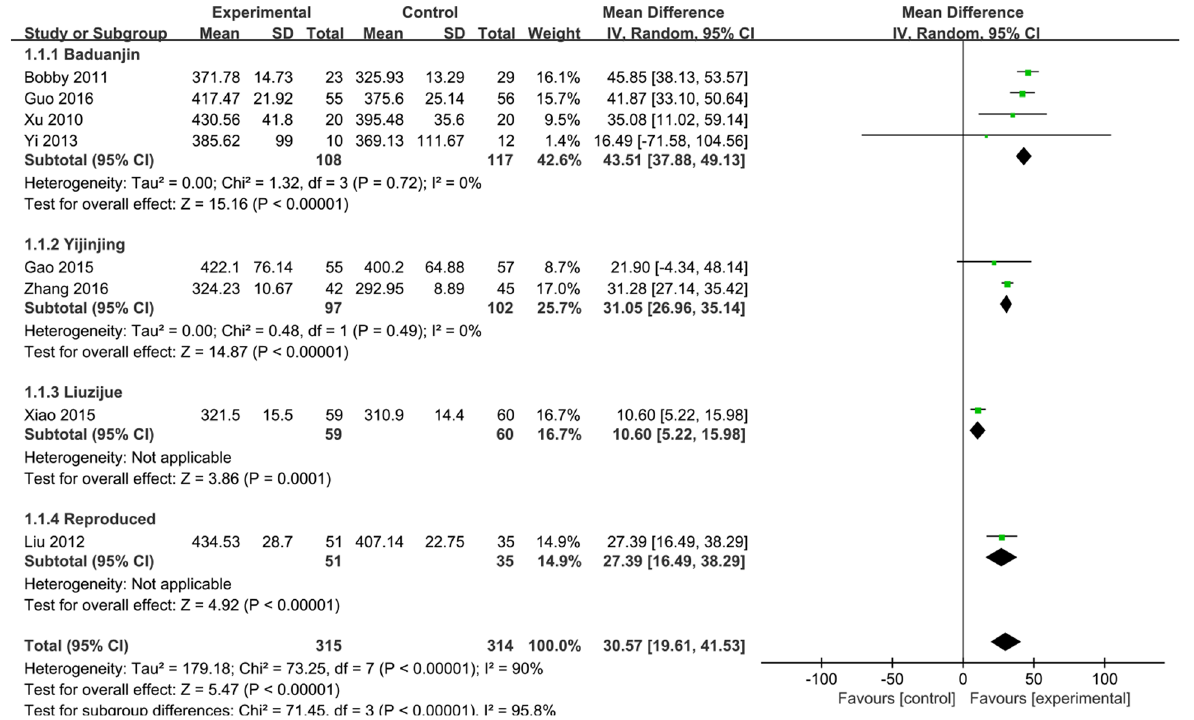
Fig. 2 Effects of Qigong on the 6-min walk distance (6MWD). Subgroup meta-analysis was used to assess the effects of different types of Qigong on the 6MWD with a fixed effects model